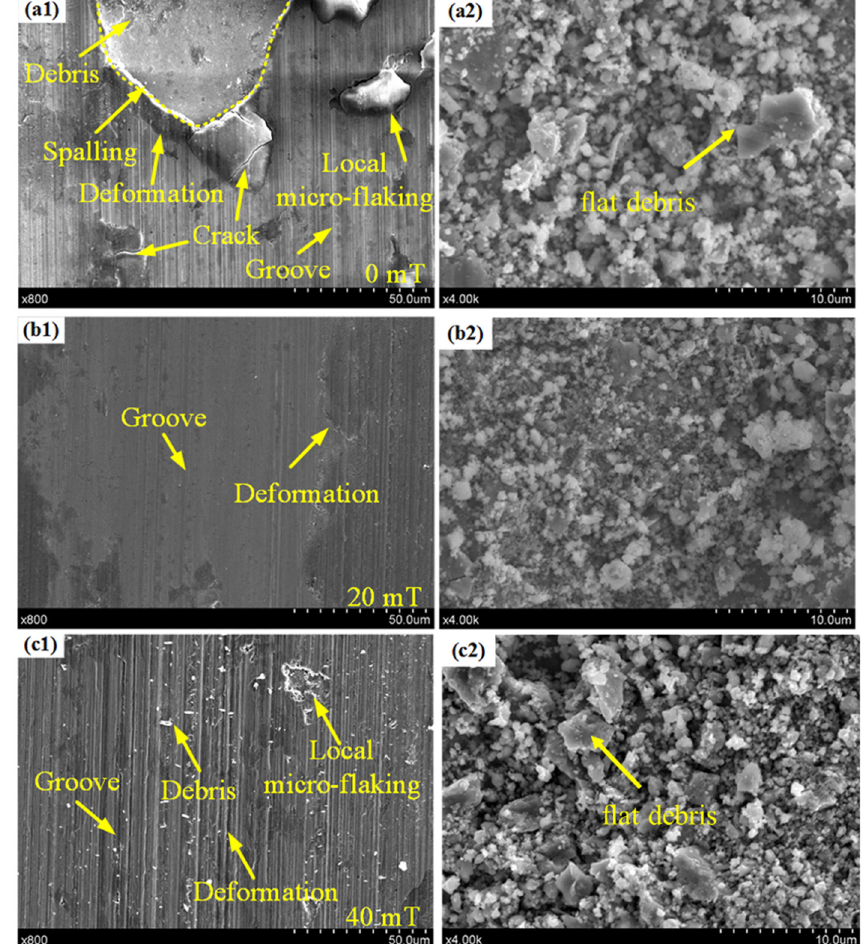
Figure 10. Comparison of local morphology of wear scars ( a1 – c1 ) of coating A (0 mT), B (20 mT), and C (40 mT); and wear debris ( a2 – c2 ) of coatings A (0 mT), B (20 mT), and C (40 mT).